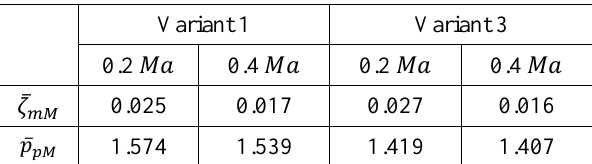
Table 4. Blade cascade parameters.